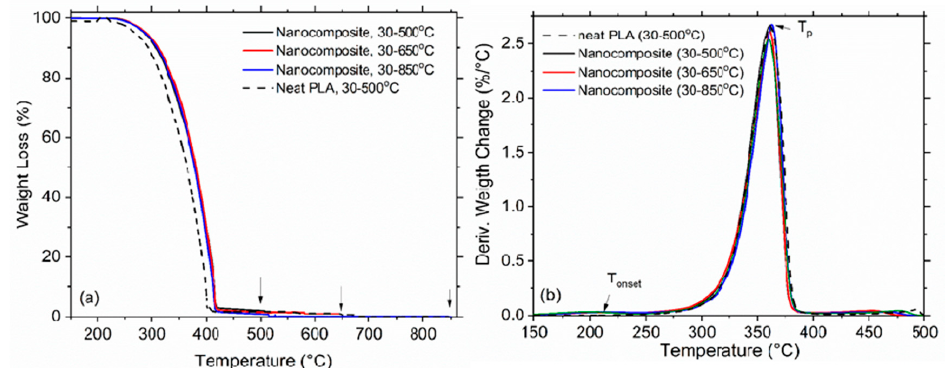
Figure 3. TGA ( a ) and DTG ( b ) curves of the neat PLA and GNP/MWCNT/PLA nanocomposite film compared to the neat PLA at three temperature regimes, 500, 650 and 850 °C, in an air atmosphere. Table 1. Thermal characteristics of PLA and GNP/MWCNT/PLA nanocomposite by TG analysis.